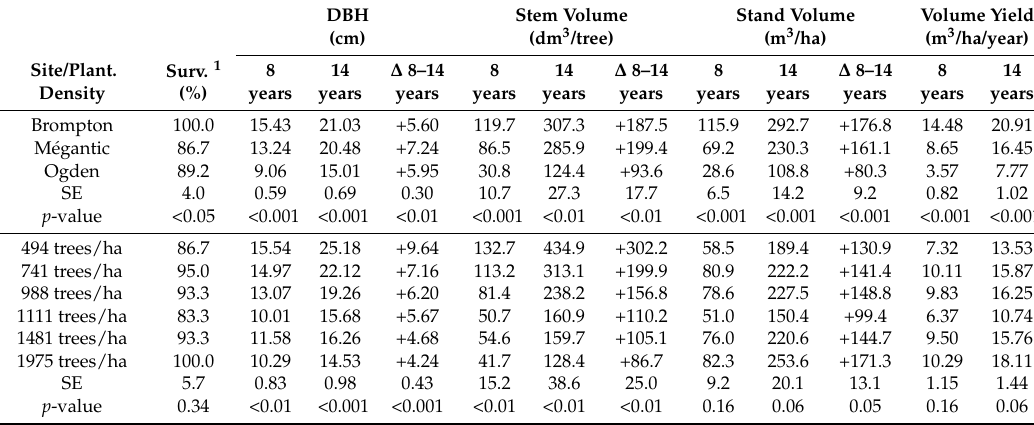
Table 3. Site and Planting density effects on survival rate, DBH, stem volume, stand volume and volume yield after 8 and 14 years in hybrid poplar plantations.